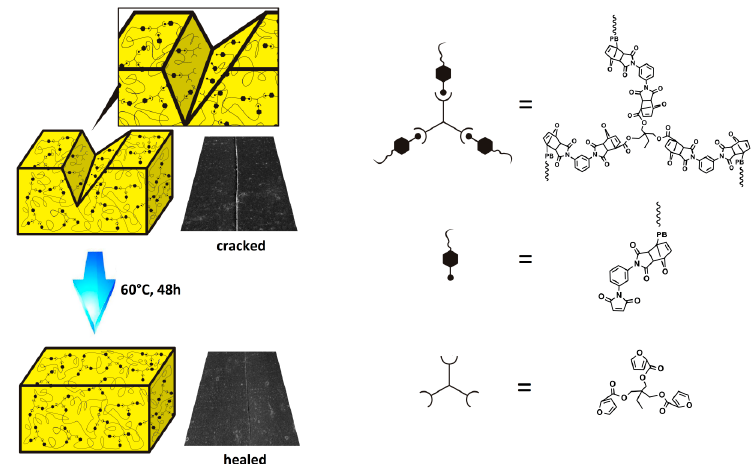
Figure 8. Thermoreversible self-repairing process and scanning electron microscope (SEM) images of FTPB-PDMI film before and after repairing.